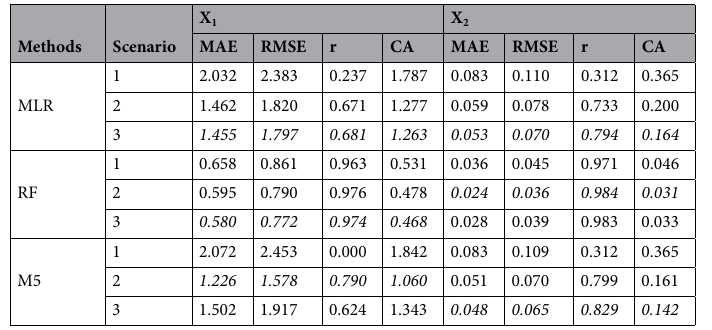
Table 3. The suitable group of independent variables for determining two GR2M parameters.